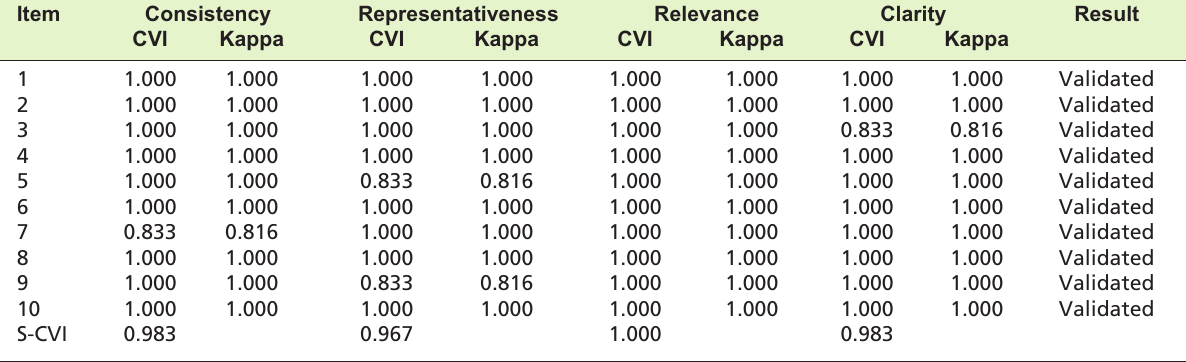
Content validity for item-level (I-CVI), scale-level (S-CVI) and Kappa values for each item Table II: Item